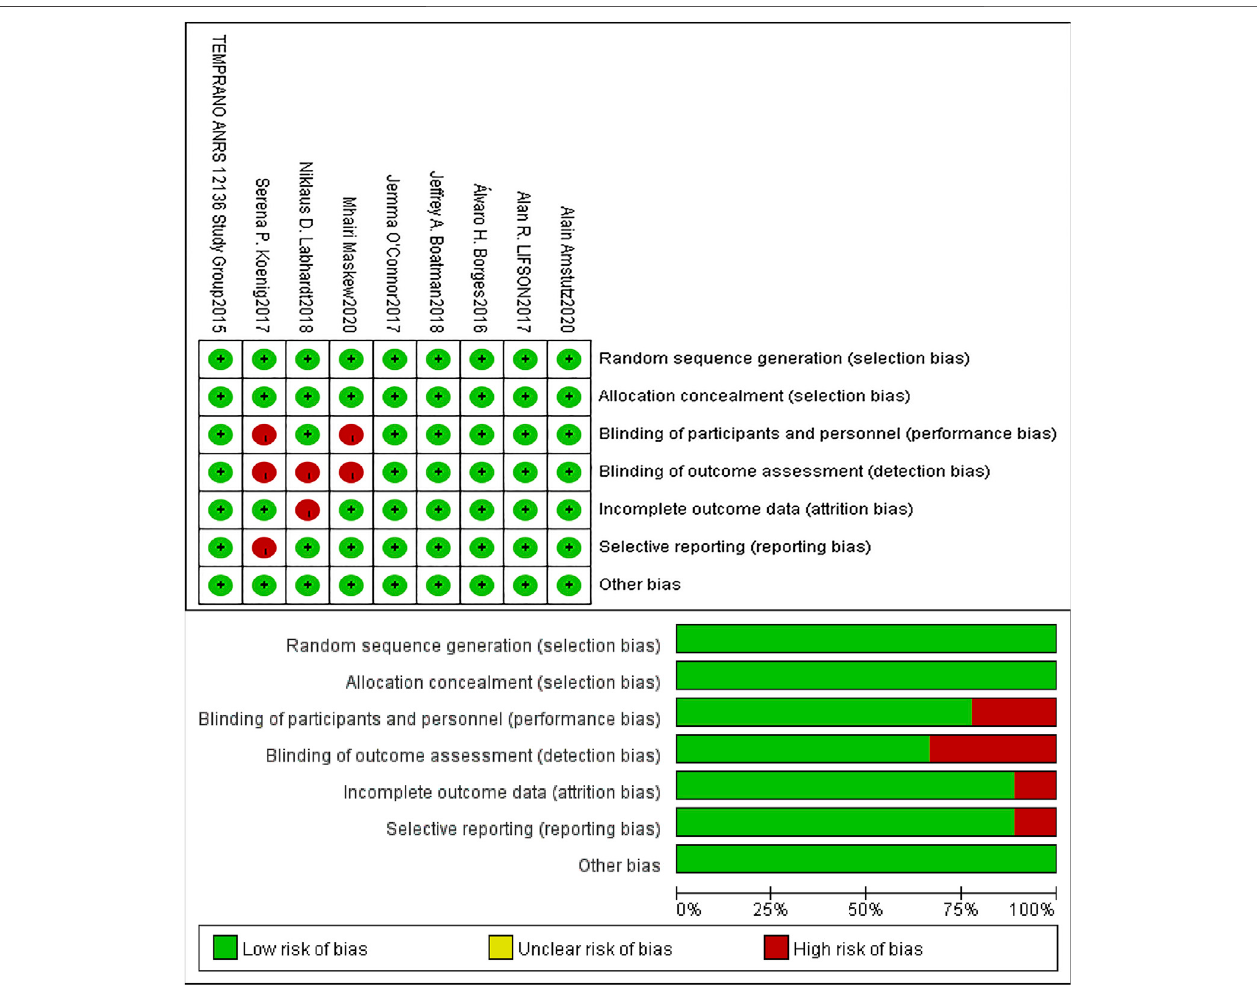
FIGURE 2 | Risk of bias summary and